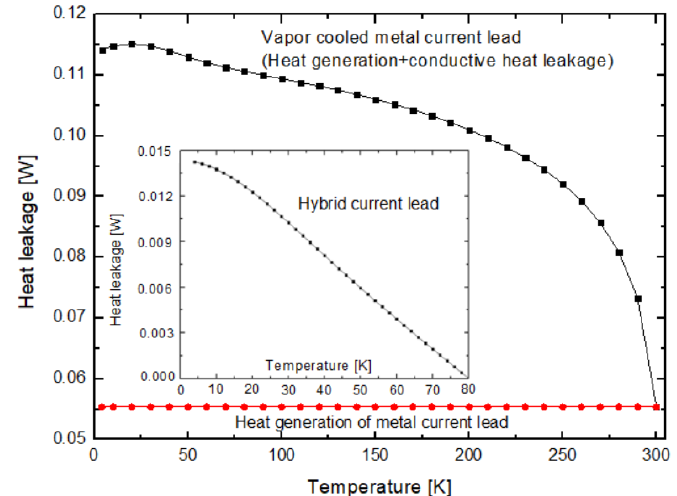
Figure 7. Heat leakages of vapor-cooled and hybrid current leads.